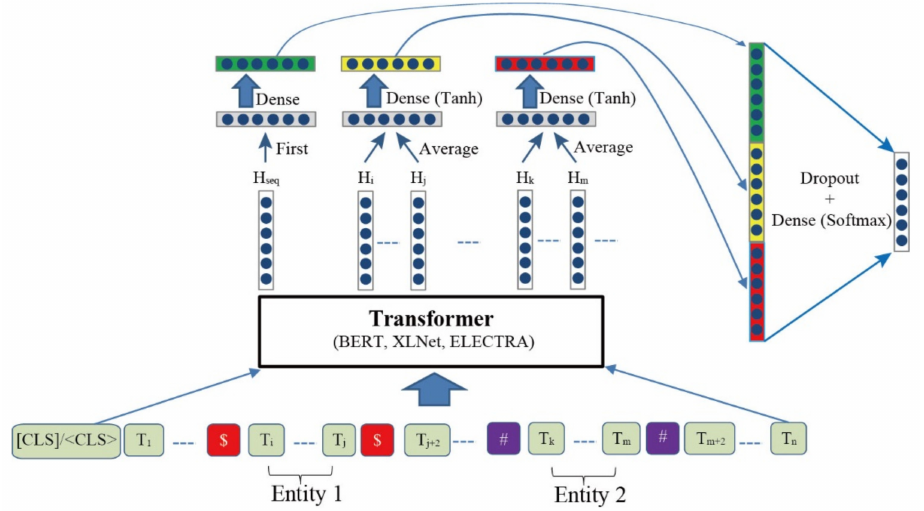
Figure 5. R-Transformer models for relation classification.